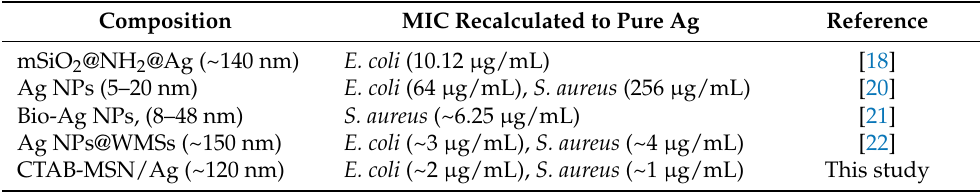
Table 1. Minimum inhibitory concentration (MIC) data for some Ag and SiO 2 –Ag